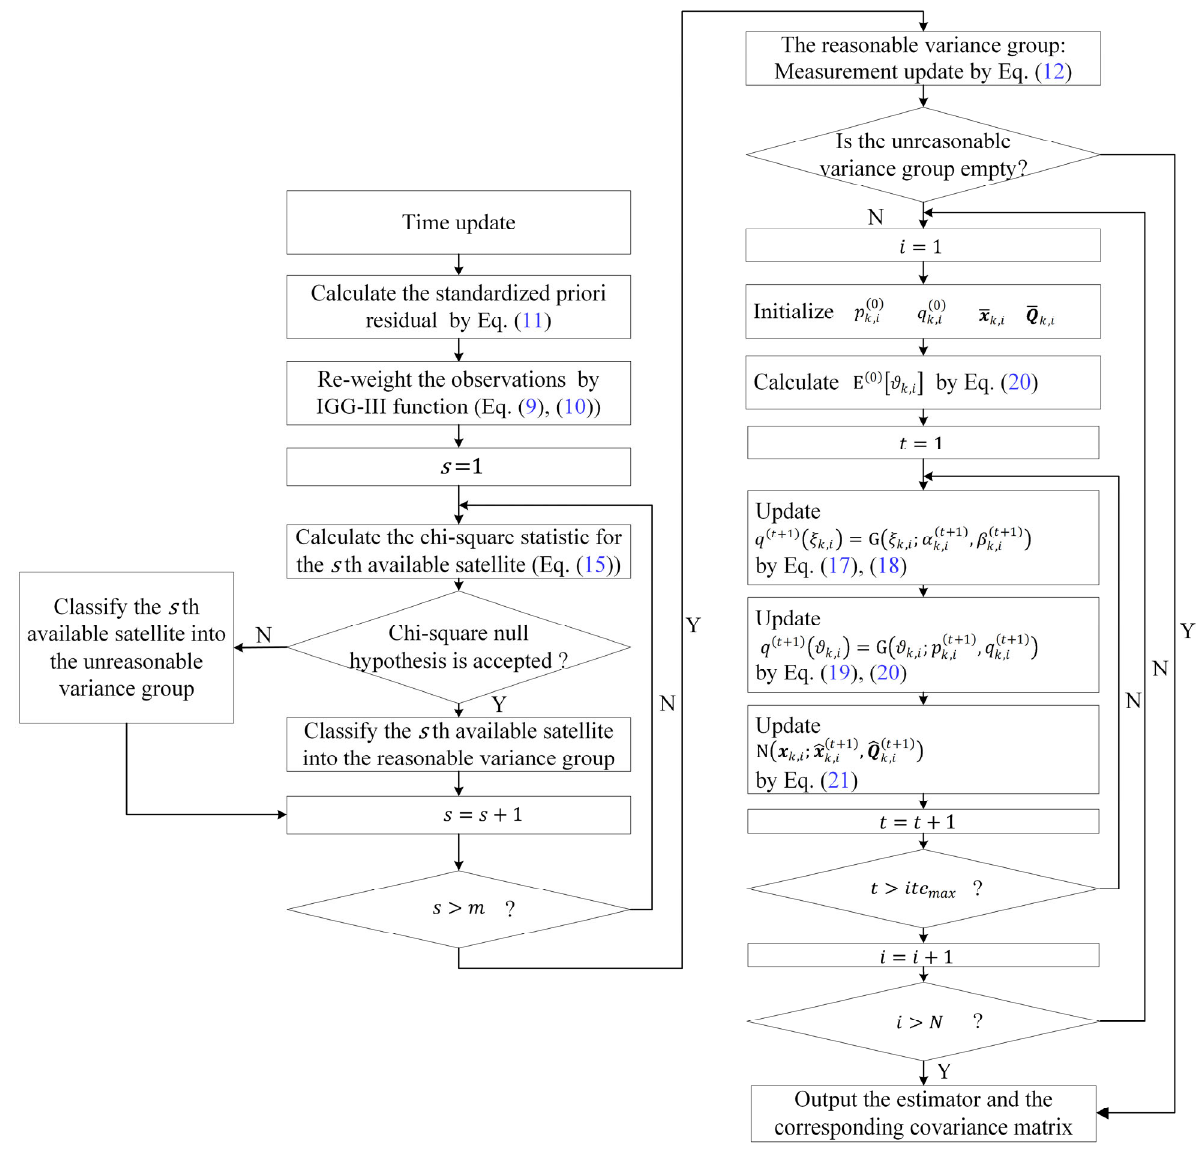
Figure 4. Flow chart of the SSTRKF.